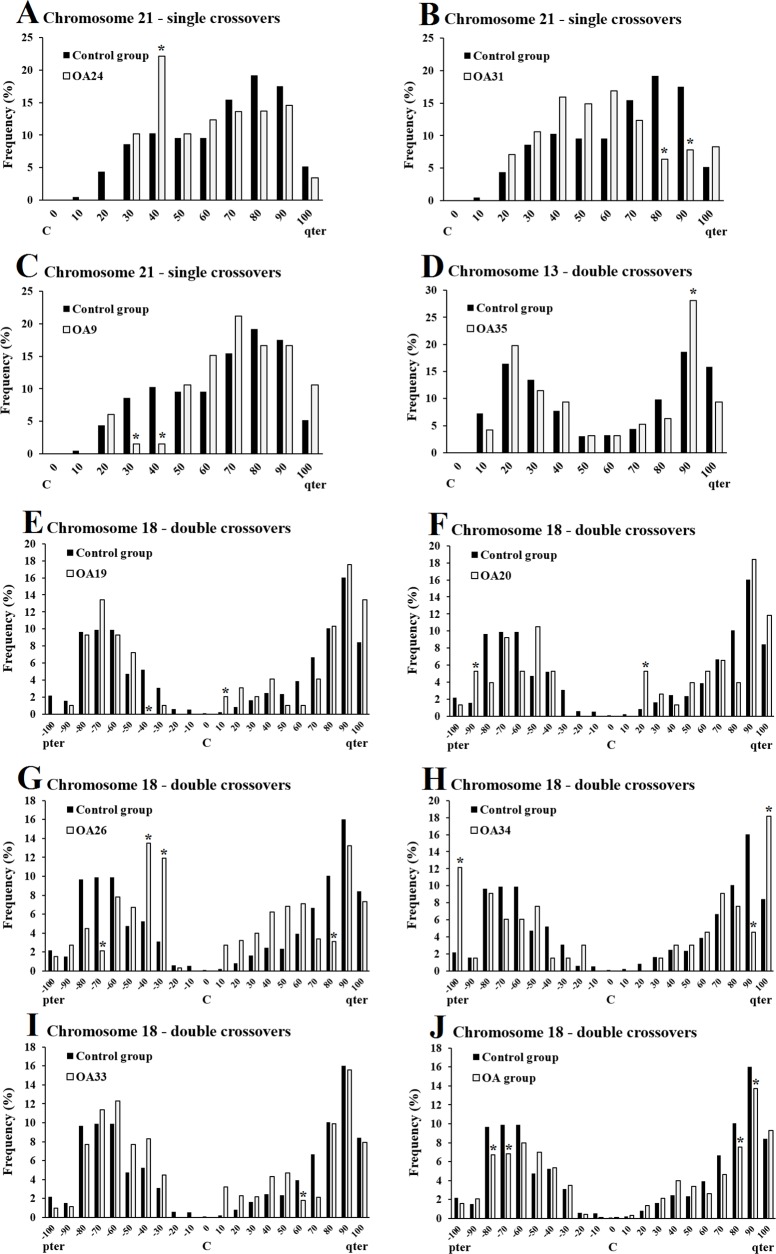
Chromosomes 21, 13 and 18 displaying altered crossover distributions in OA men.The Y-axis represents the frequency of crossovers in each interval. The X-axis represents the relative crossover position from the centromere with the values representing the upper limit of each interval. As crossovers in the p-arm of chromosomes 13 and 21 are extremely rare, the p-arms are not shown. The black bars indicate the control group and the white bars indicate the individual OA man (A-I) and pooled OA group (J). The crossover frequencies in each interval were compared to the control group and significant differences are indicated by asterisks (P < 0.05, Fisher test).